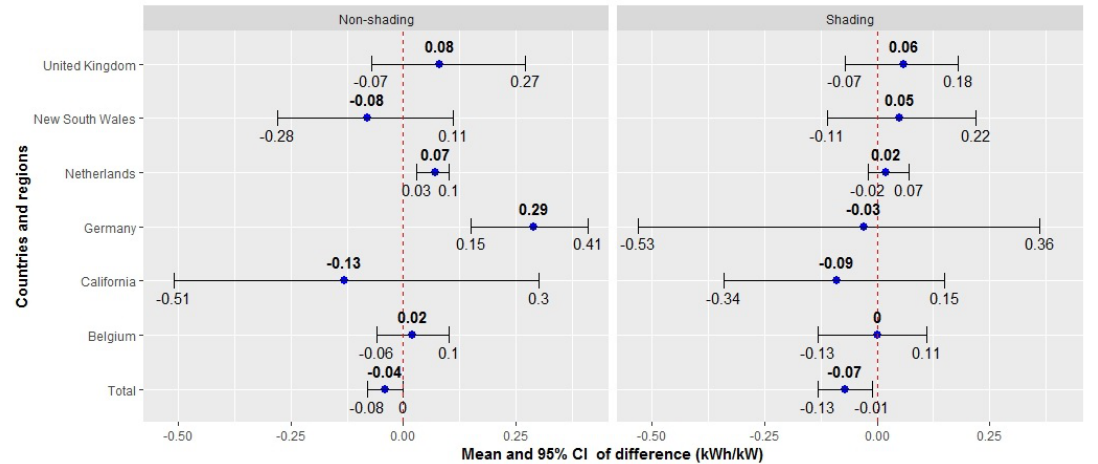
Figure 4. Comparative results of the differences in lifetime energy yield ( Y L ) between the PVs that use SMAinverter and PVs that use other inverters using bootstrap technique (Algorithm